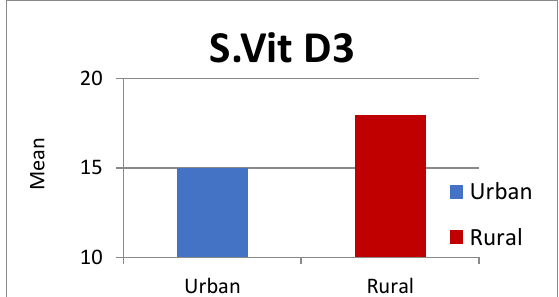
Figure 1: Descriptive and statistical tests of Vitamin D3 among